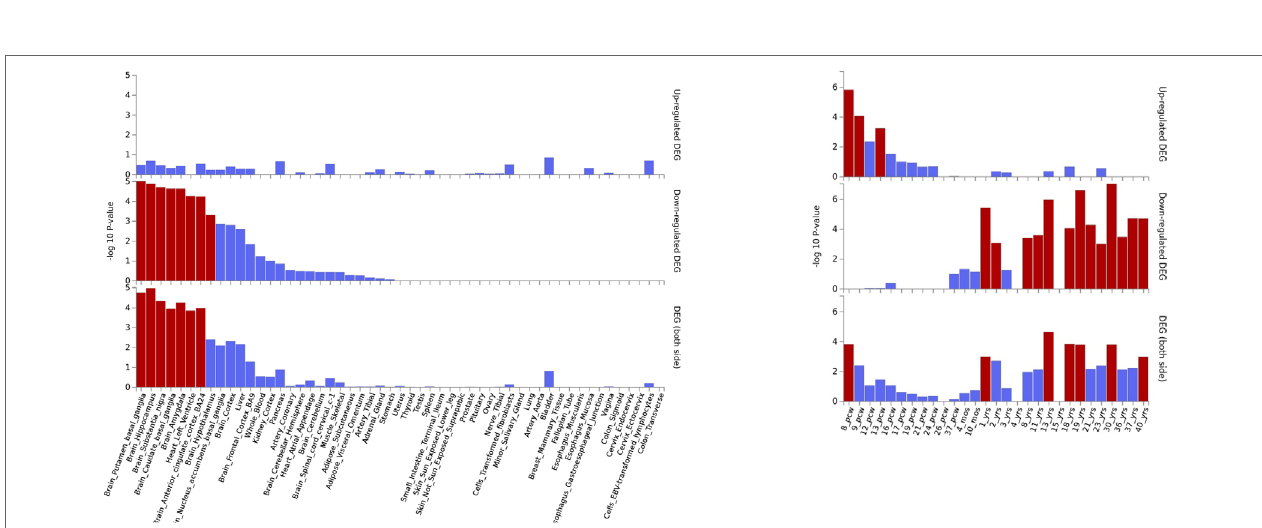
FIGURE 4 | ASD DEG plots constructed with GTEX v7 (53 tissues) (left) and BrainSpan 29 different ages of brain samples data (right). Significantly enriched DEG sets (Pbon < 0.05) are highlighted in